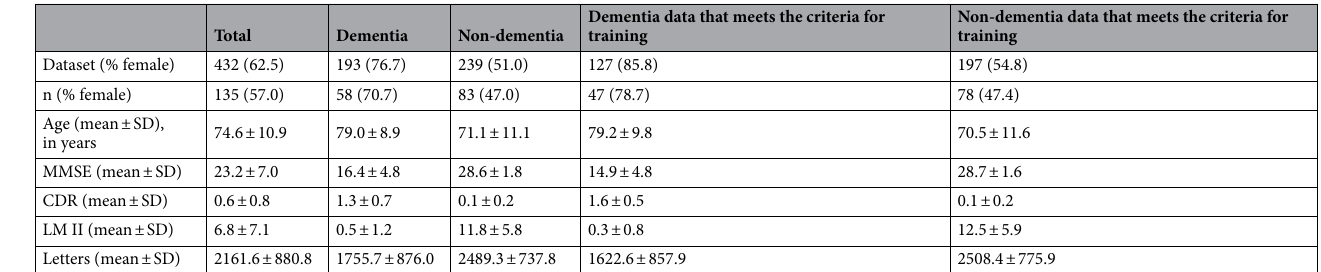
Table 1. Demographic data. Non-dementia includes cognitively healthy controls and participants with mild cognitive impairment. Criteria for training: criteria for datasets obtained from neuropsychological tests to be used as training data for machine learning. MMSE mini-mental state examination, CDR clinical dementia rating, LM II logical memory delayed recall of Wechsler Memory Scale-Revised, Letters: Number of letters uttered by the subject in the recorded free